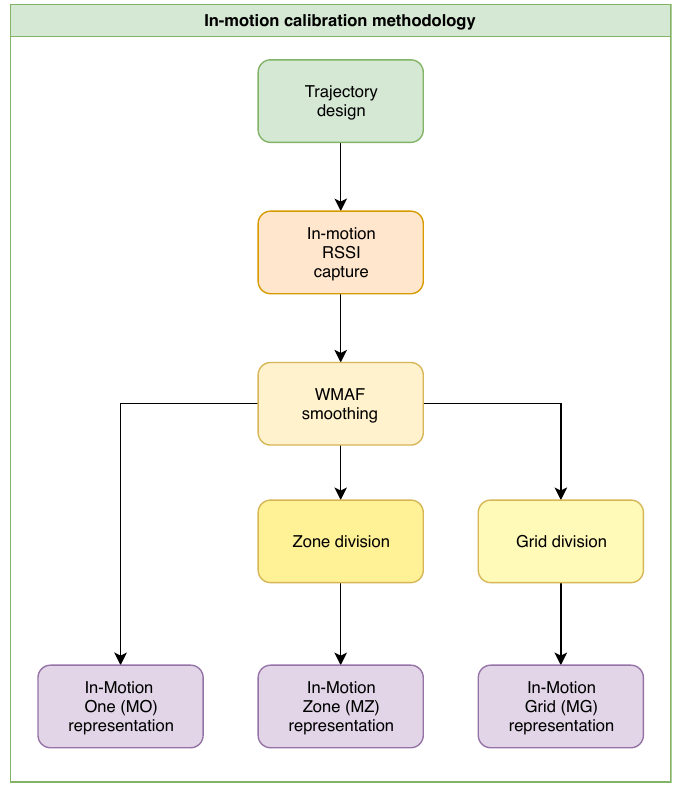
Figure 6. In-motion calibration methodology procedure. Window Moving Average Filter